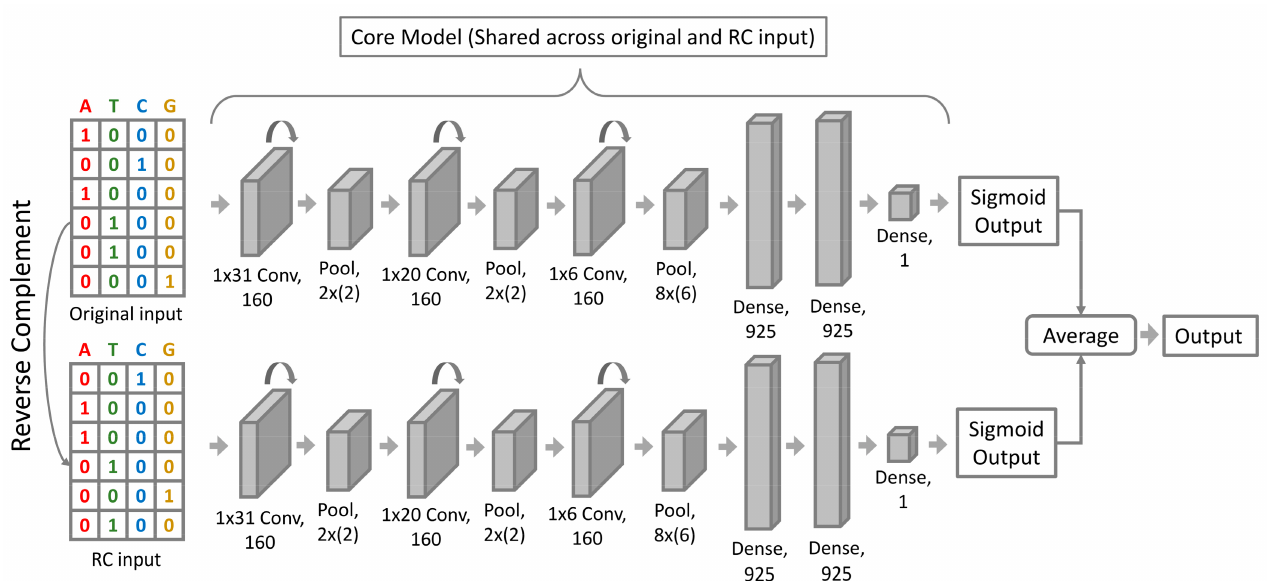
Figure 2. InsuLock’s Siamese neural network architecture: To the binary classification model, the one-hot encoded matrix of both the forward and reverse complementary sequences are fed, and the sigmoid predictions of both the strands are averaged out to provide the final anchor prediction. The neural network architecture is composed of 3 convolution blocks, where each block contains a convolution and a pooling layer, which is followed by 3 dense